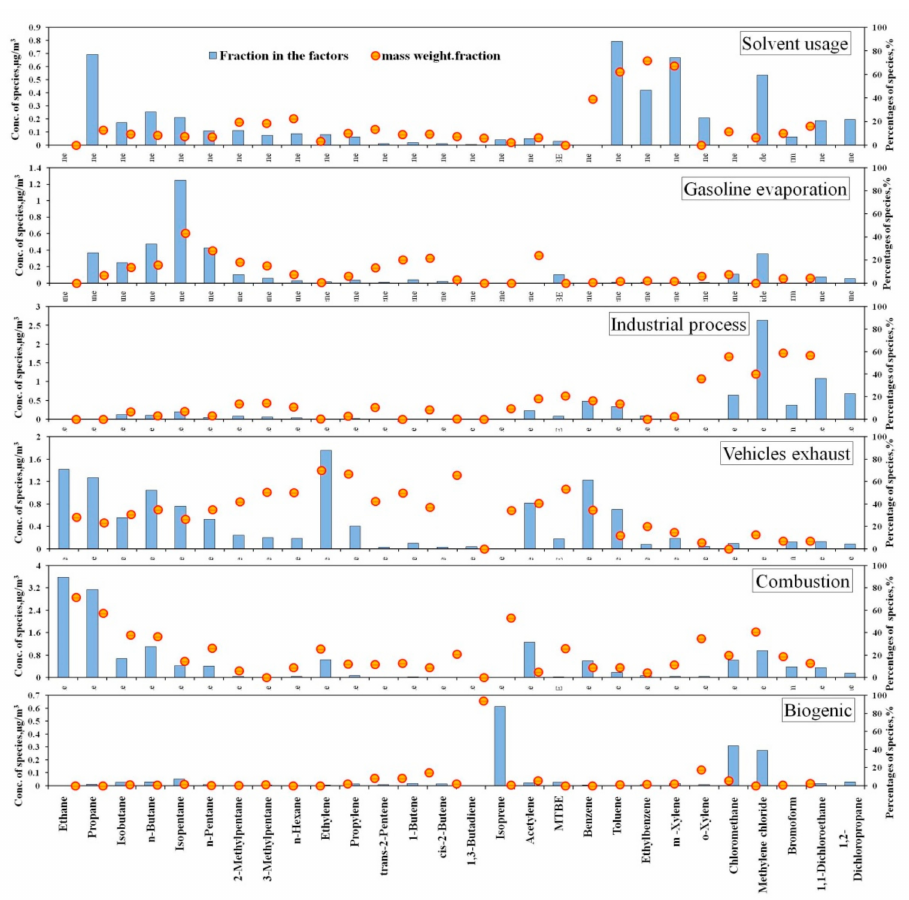
Figure 6. The concentration and factor profiles of each source for the entire